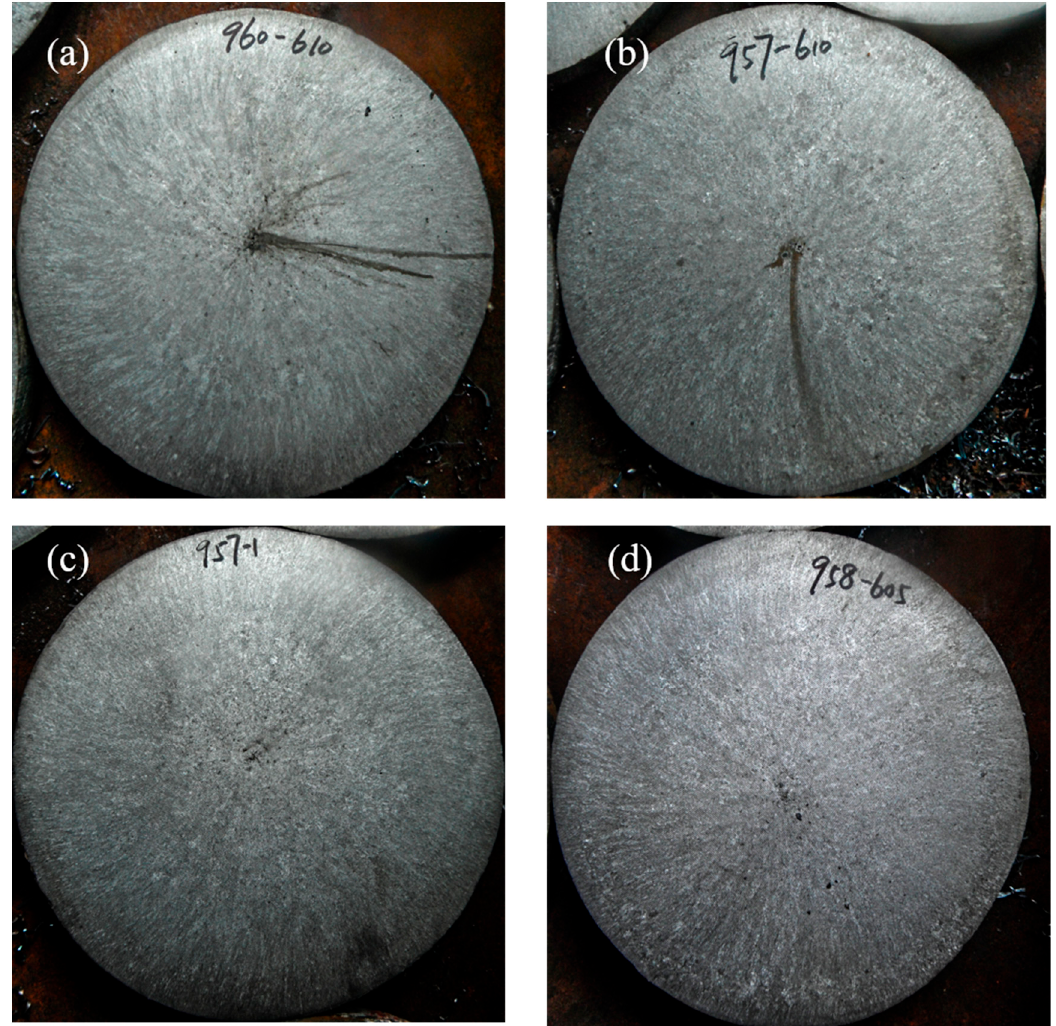
Figure 8. Low-power images of round billet samples produced according to the ( a ) original process, ( b ) scheme I, ( c ) scheme II, and ( d ) scheme III, where the casting billet diameter is 178 mm.